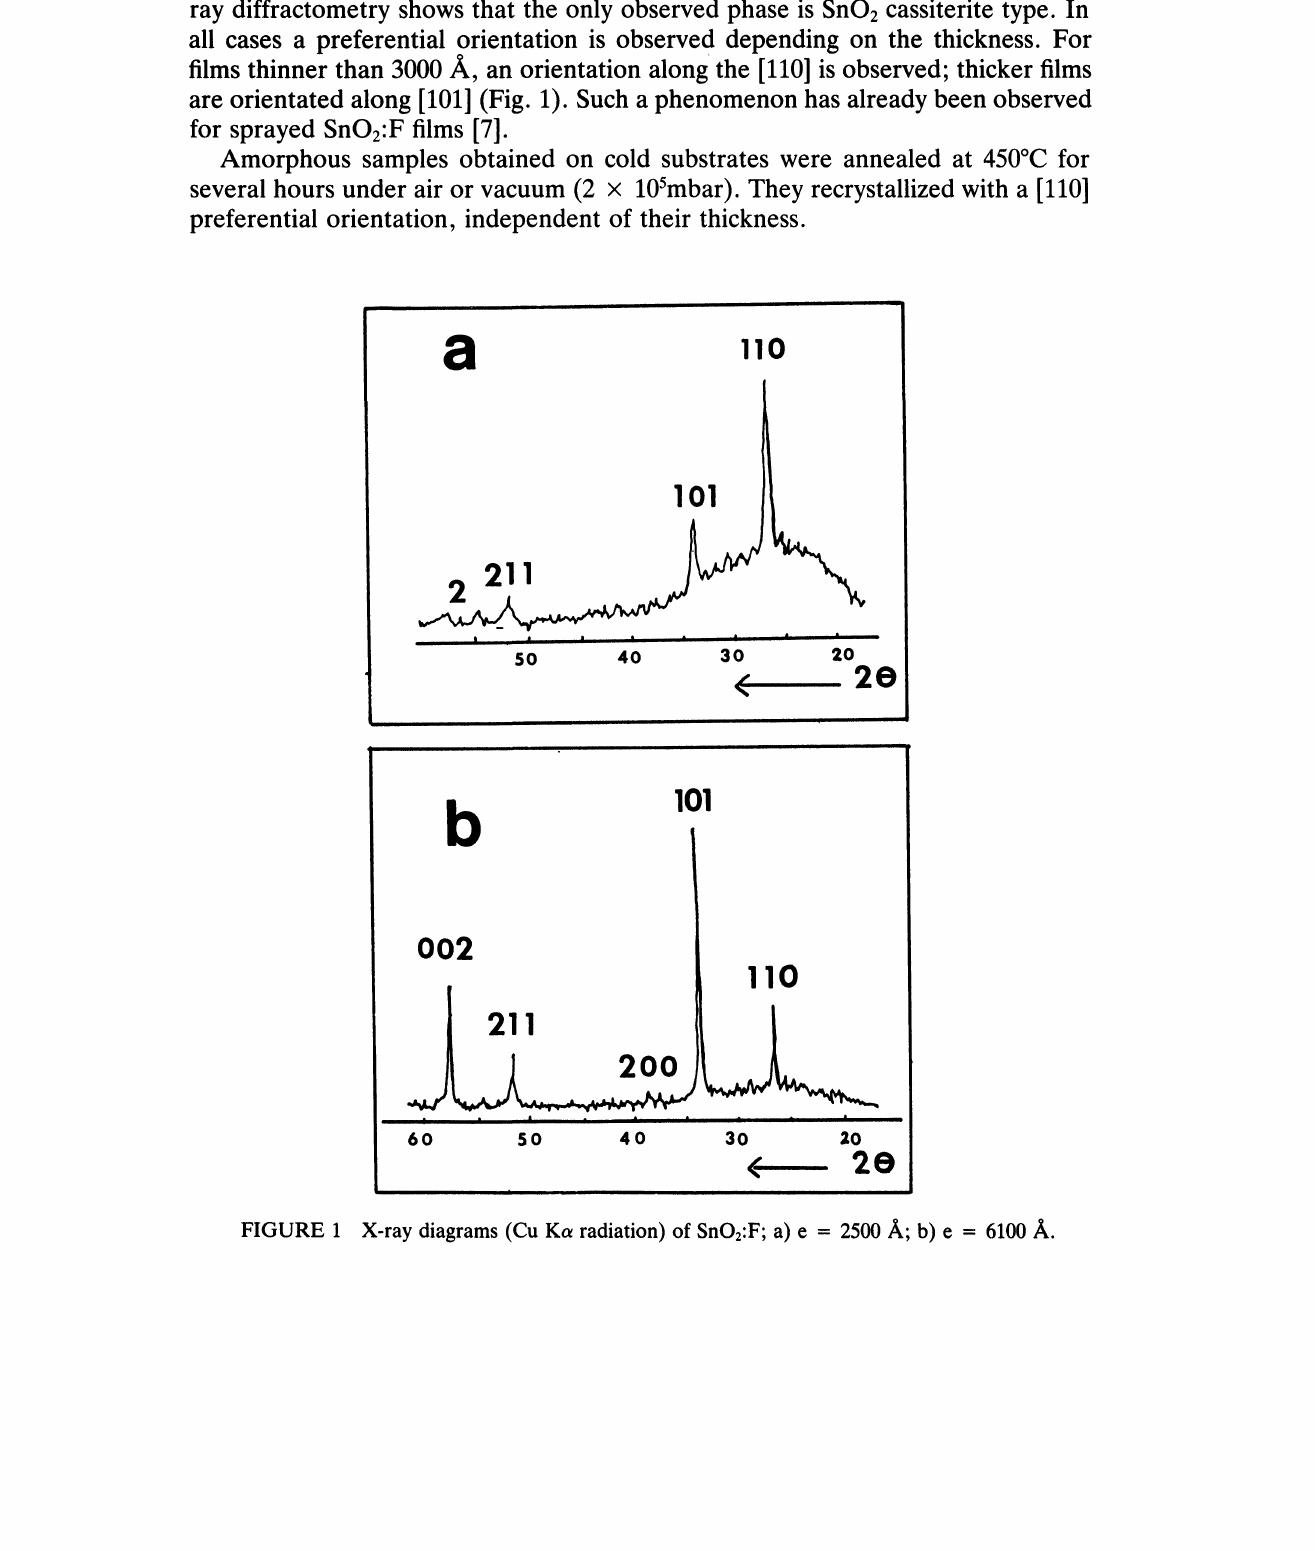
FIGURE X-ray diagrams (Cu Ka radiation) of SnO2:F; a) e 2500/; b) e